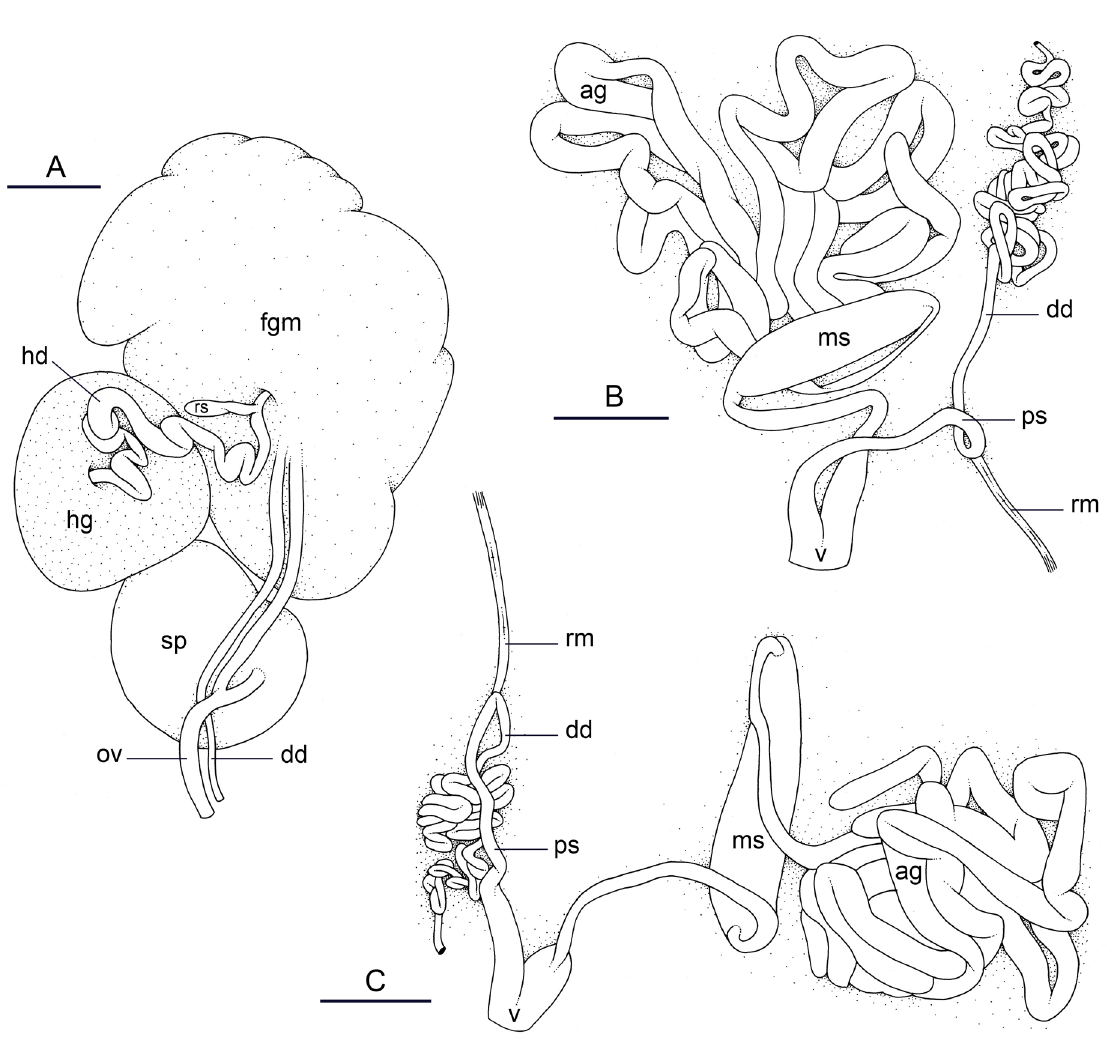
Fig. 16. Paromoionchis tumidus (Semper, 1880) comb. nov. unit #1, reproductive system. A . Posterior hermaphroditic (female) reproductive system, Australia, Northern Territory [1634] (NTM P.57620). B . Male copulatory organs, Philippines, Bohol [3344] (PNM 041258). C . Male copulatory organs, lectotype of Onchidium tumidum (ZMB 39019a). Abbreviations: ag = accessory penial